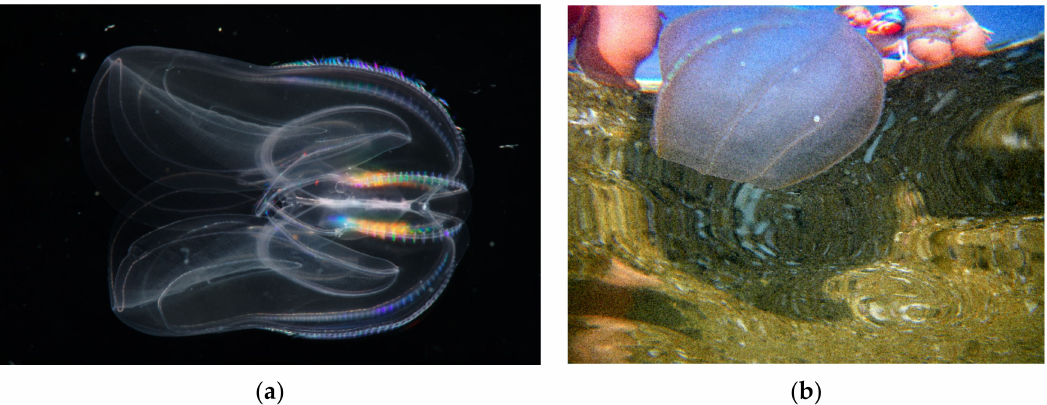
Figure 18. ( a ) Mnemiopsis leidyi (Courtesy by Bruno C. Vellutini—Own work, CC BY-SA 3.0, https://commons.wikimedia. org/w/index.php?curid=30155106, accessed on 18 July 2021); ( b ) Beroe ovata (Courtesy by Cristian Chirita—Own work, GFDL, https://commons.wikimedia.org/w/index.php?curid=10994369, accessed on 18 July